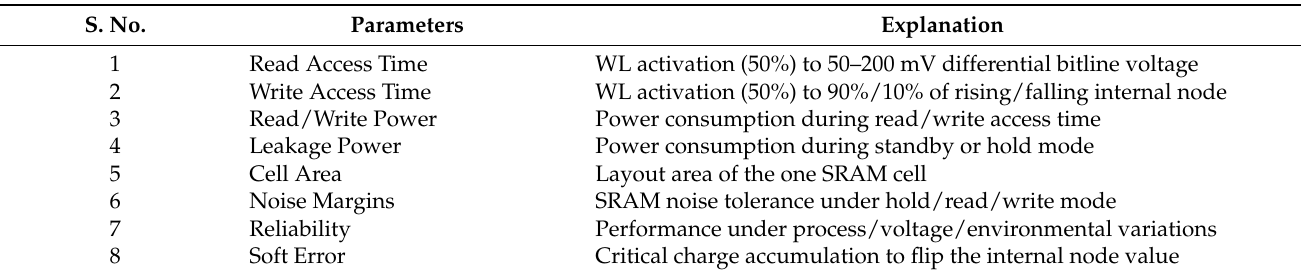
Table 1. Performance evaluation parameters for SRAM cells.